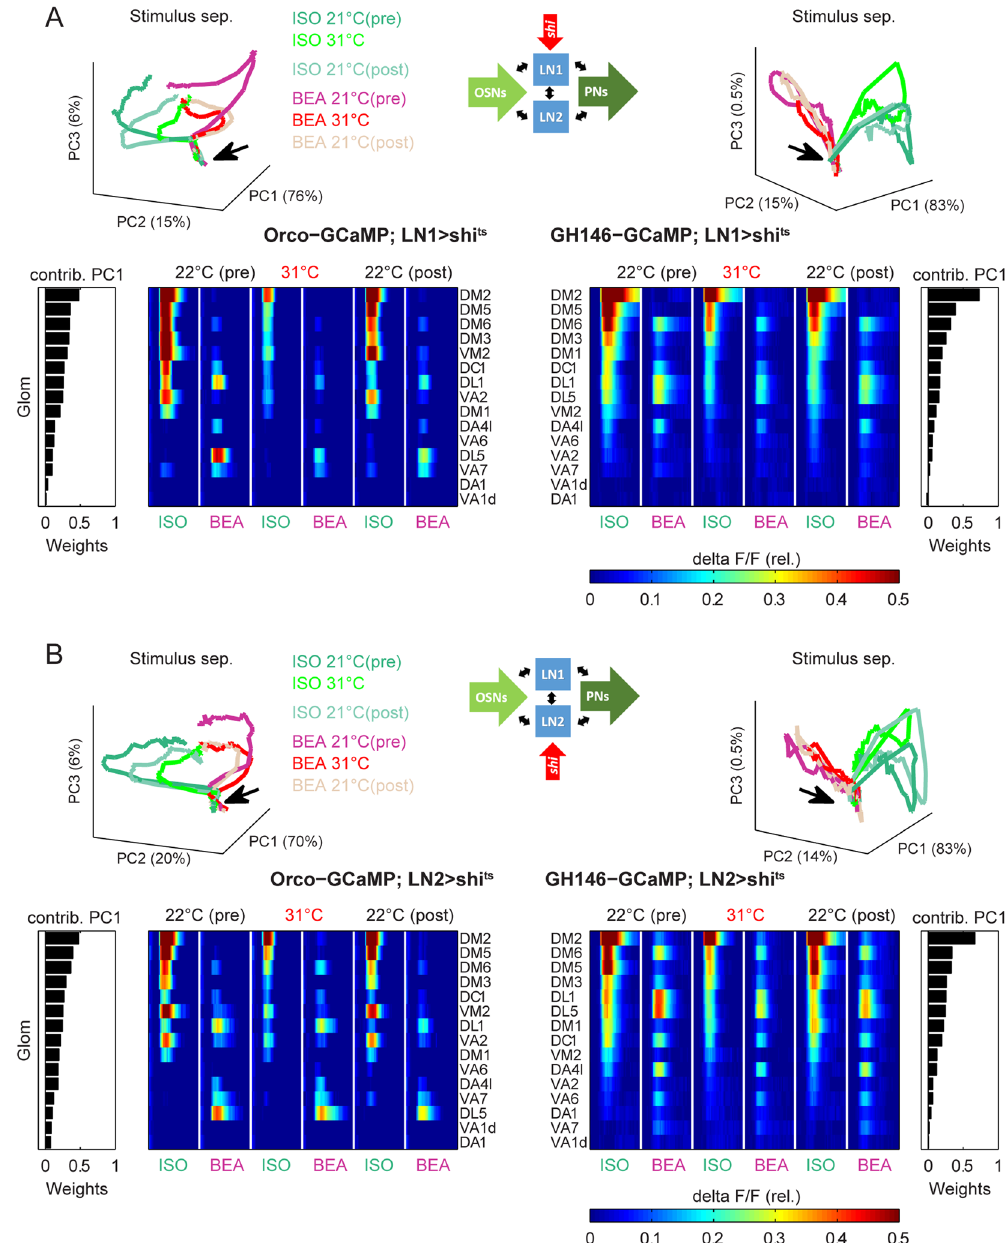
Figure 5. Silencing synaptic transmission of LN1 or LN2 has no influence on the spatial glomerular activity. ( A ) Principal component analysis of odor-evoked calcium responses of flies with silenced LN1-output for the OSN (left) and the PN level (right). Trajectory plots of the first three principal components (PC1, 2 and 3) show a clear separation of ISO and BEA in all experimental phases at both processing levels. The variation explained by the individual PCs is given at the axes. Black arrows mark the baseline activity before odor onset. During temperature increase (silencing LN1-output) the trajectories are strongly collapsed at the OSN level. The factor loadings (weights) of the single glomeruli were used to order them with respect to their contribution to the variability of PC1 for the OSN activity (most left) and the PN activity (most right). The false color coded matrix including the averaged mean fluorescence change is shown for both processing levels with respect to this ordering. The spatial activity patterns at both processing levels (OSNs and PN) were not affected by the temperature shift. However, the calcium signal strength decreased strongly during the temperature increase and recovered during the permissive temperature in the recovery phase (22 °C (post)). ( B ) Same representation as in A for flies with silenced